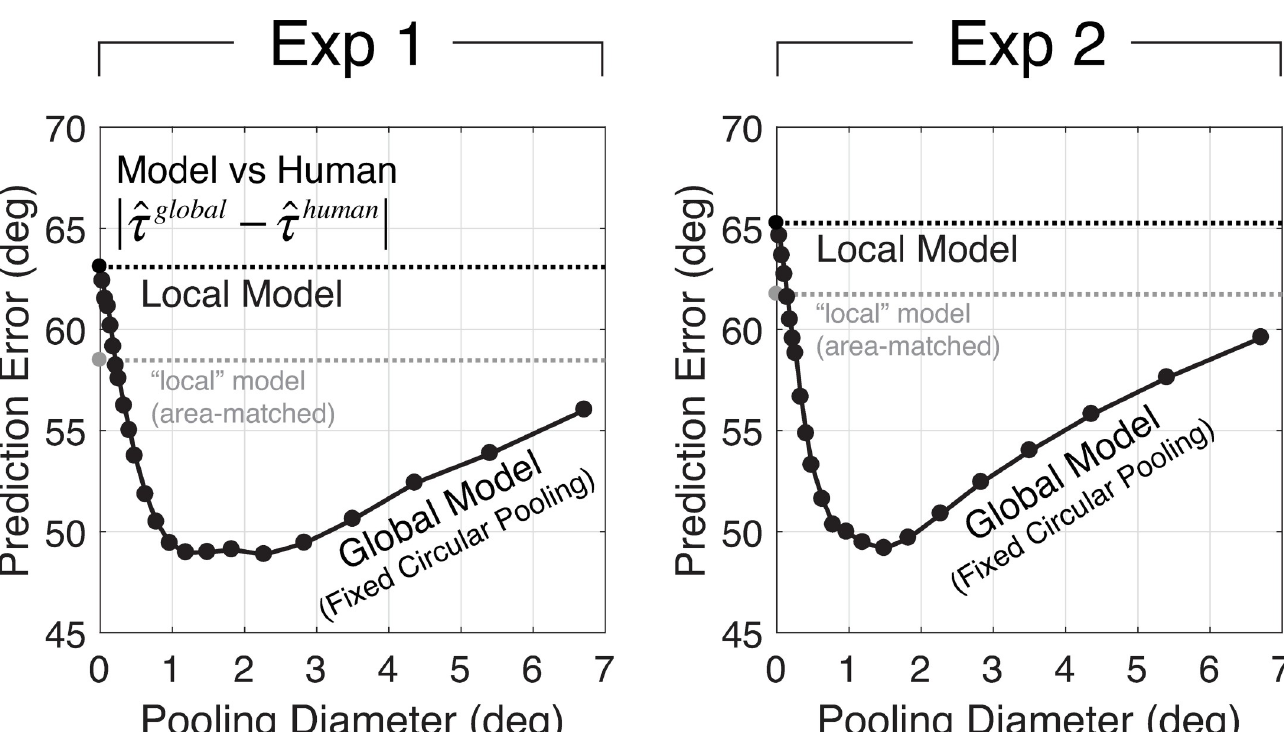
Fig 8. Human prediction error from the global model with fixed circular pooling. Mean prediction error is plotted as a function of the diameter of the pooling region. Mean prediction errors are computed across all tilts and human observers. The black dashed line indicates the mean prediction error for the local model. The gray dashed line indicates the prediction error for a “local” model that computes the image cues from an area matched to that implicitly used by the best global model (see Discussion). Data from Exp 1 and Exp 2 are shown in the left and right columns, respectively.